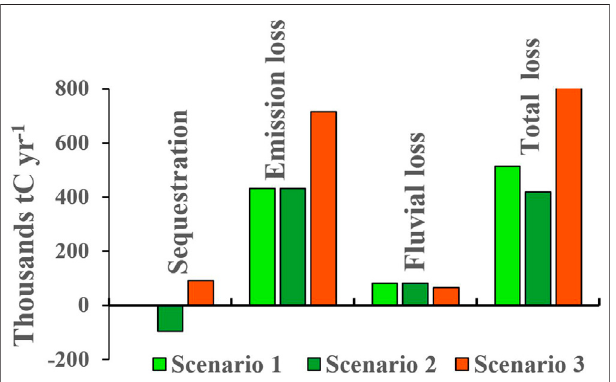
FIGURE 7 | Components of the carbon loss in our study